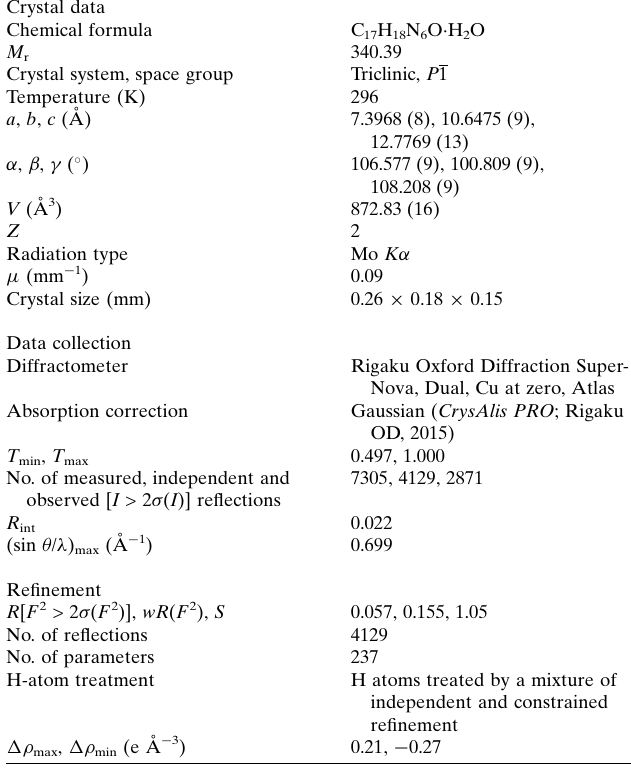
Table 2 Experimental details.